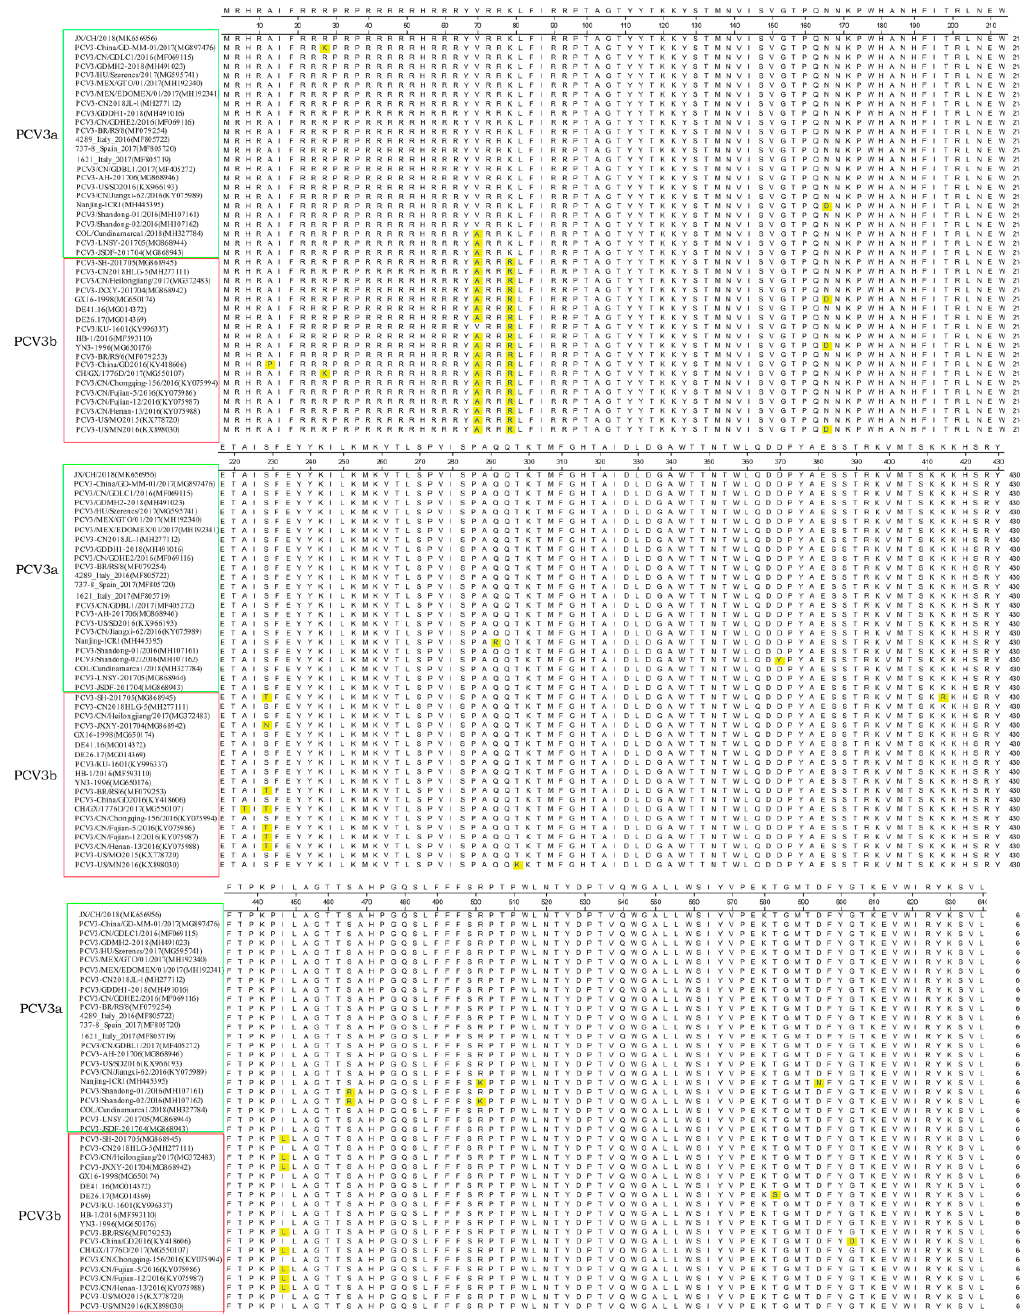
Figure 1. Alignment analysis of the amino acid sequences of the capsid genes between the identified PCV3 strain JX/CH/2018 and reference PCV3 strains.